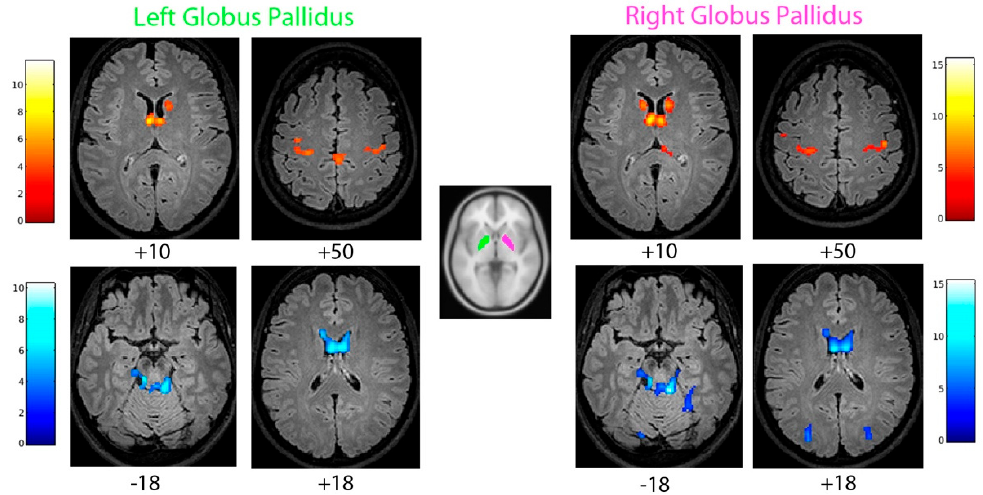
Figure 2. Increased ( top ) and reduced ( bottom ) functional connectivity of the patient’s left and right globus pallidus, with respect to the control group (cluster size threshold k > 95 and k > 108, corrected at α < 0.05, respectively). Clusters are shown in the axial slices of the patient’s normalized flair 3D image.